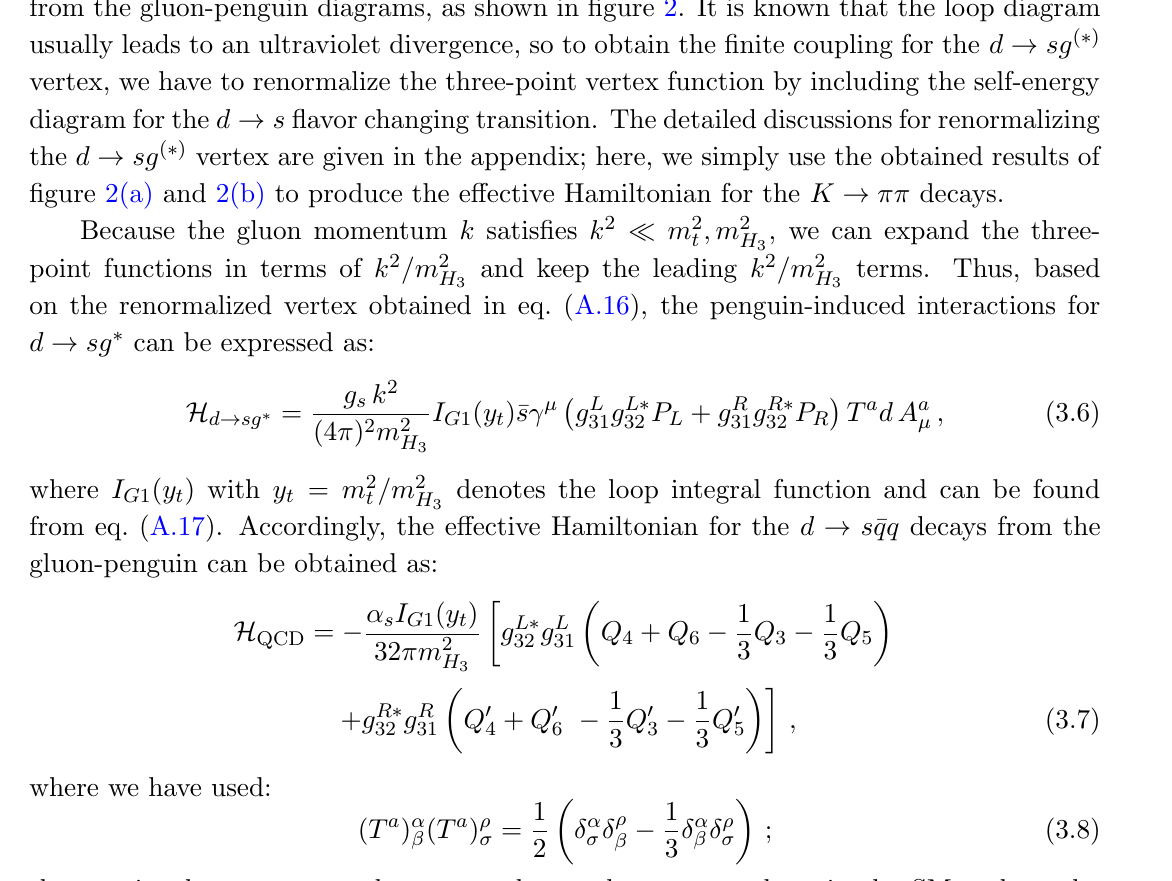
Figure 2 . Gluon-penguin diagrams for the d ! sg ( quark H 3